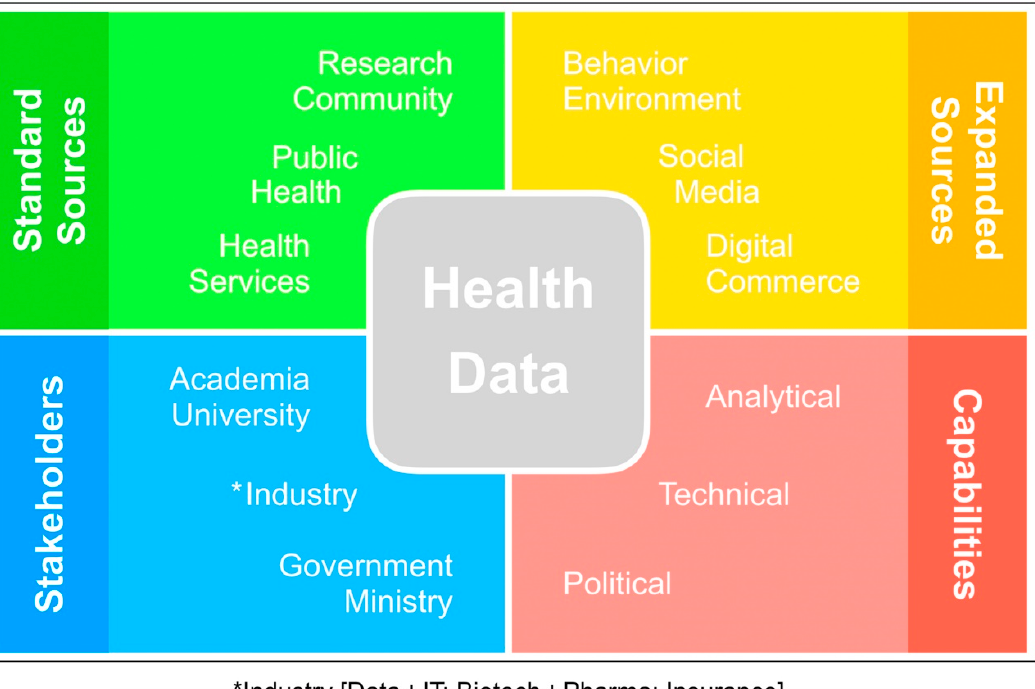
Figure 1. Health data sources, associated stakeholders and capabilities.